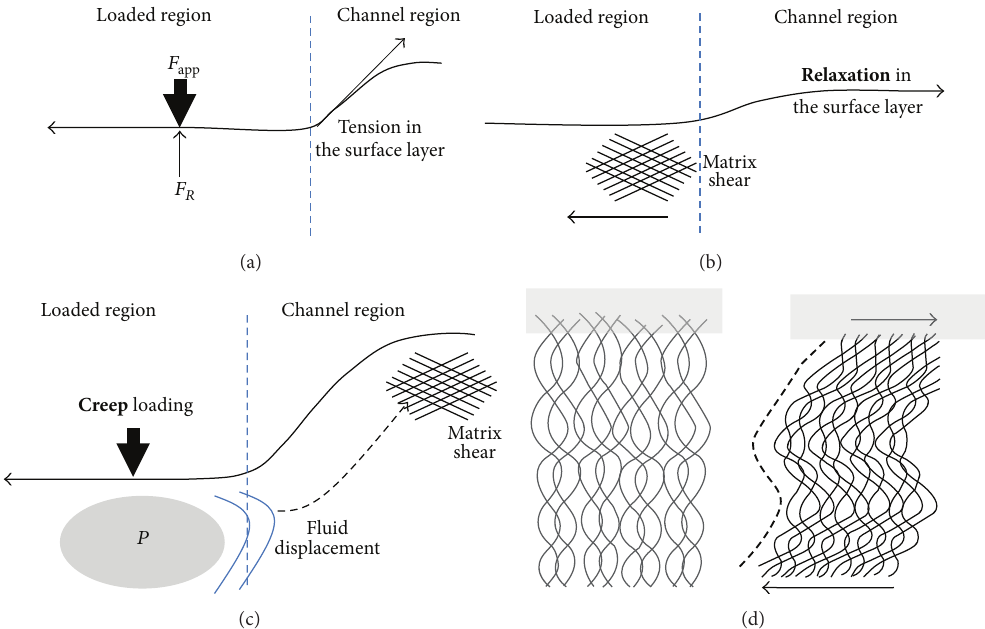
Figure 12: (a) Initial compression (𝐹 app ) of the cartilage tissue creates tension in the surface layer across the directly loaded and non-directly loaded (channel) regions. The matrix reaction is depicted by 𝐹 𝑅 . (b) With small 1MPa loads, a smaller compressive strain results, and holding the position following attainment of 1MPa allows stress relaxation in the surface layer that creates a matrix shear, manifested by the shear bands shown as crisscross pattern. (c) With creep loading of the cartilage tissue, even with small loads, a relatively large compressive strain results from tissue consolidation at this fixed load. Fluid-pressure build-up (𝑃) and fluid displacement into the channel region cause matrix shear (shear bands) to form in the bulge region. (d) Matrix shear or shear bands and how they are formed are illustrated. Shear causes in-phase crimping (indicated with the dotted line) of the interconnected fibrillar matrix that is resolvable at the microscale (refer also to Figures 6(c) and